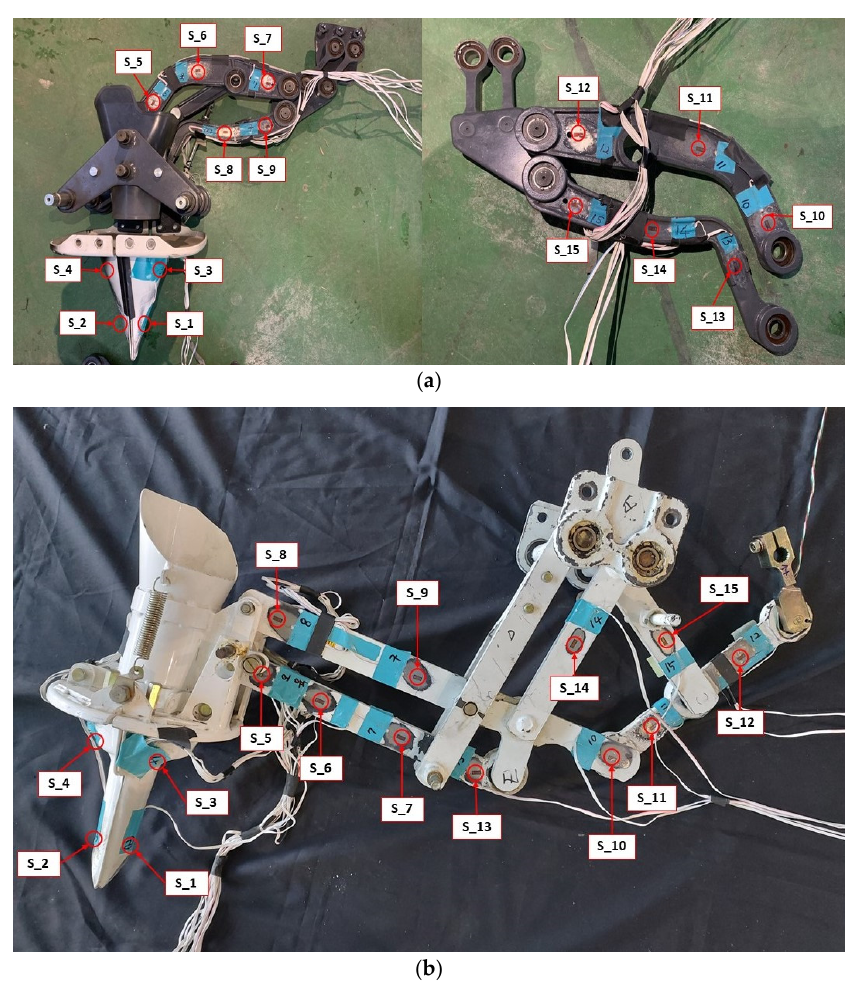
Figure 9. Location of the strain gauge on the transplanting device: ( a ) cam and ( b ) four-bar-link types. Table 3. Detailed description of strain measurement location.